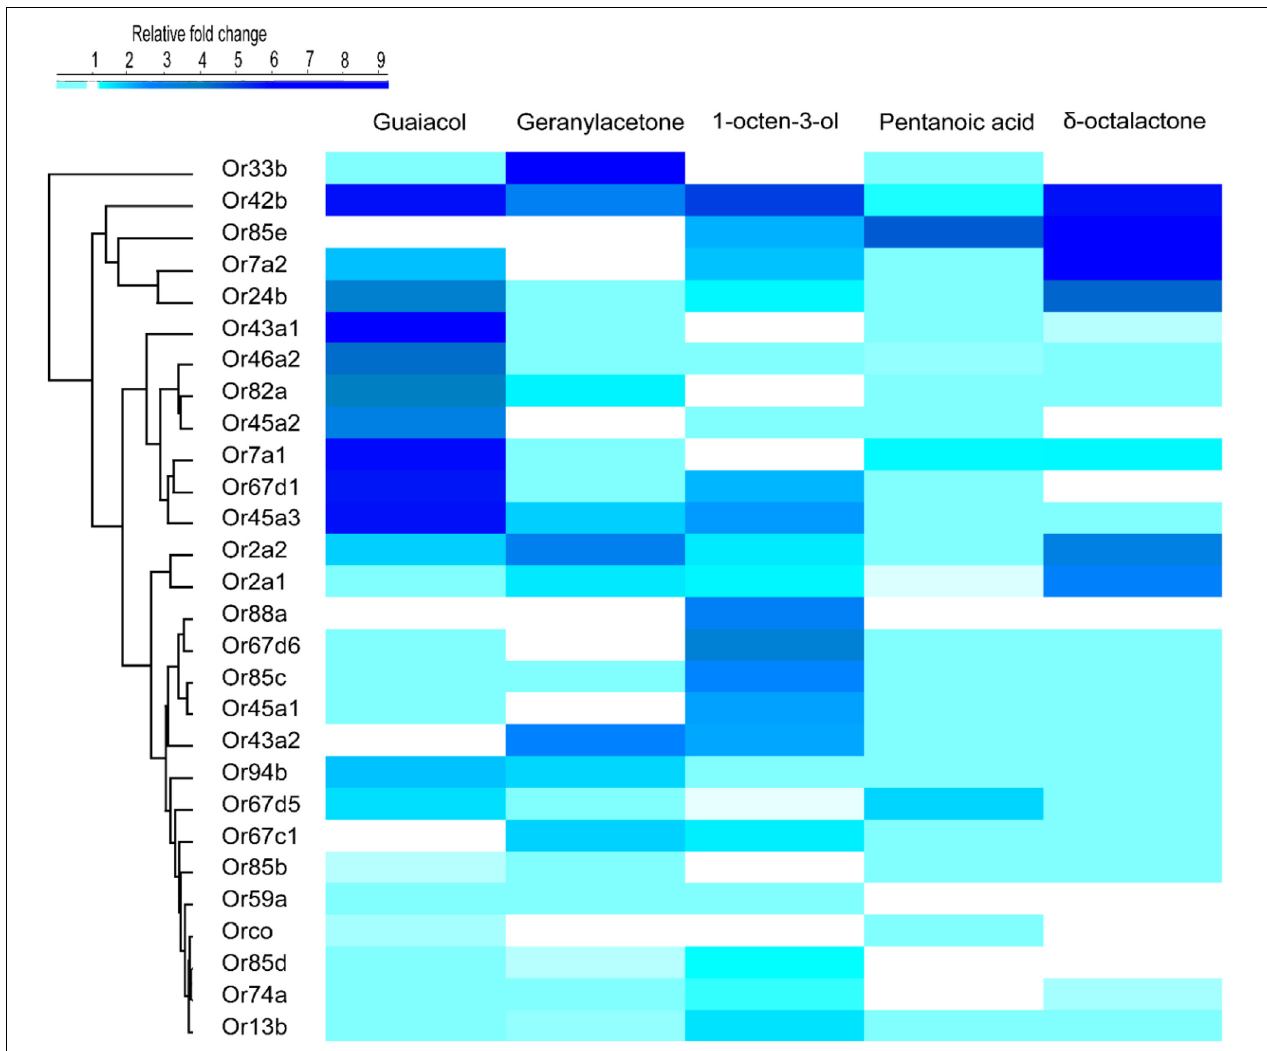
FIGURE 3 | Heat map showing the differential expression of G . f . fuscipes odorant receptors across the five odorants, generated using R software (R Core Team, 2018) (version 3.5.1) www.R-project.org, edited using adobe illustrator CS5.1.